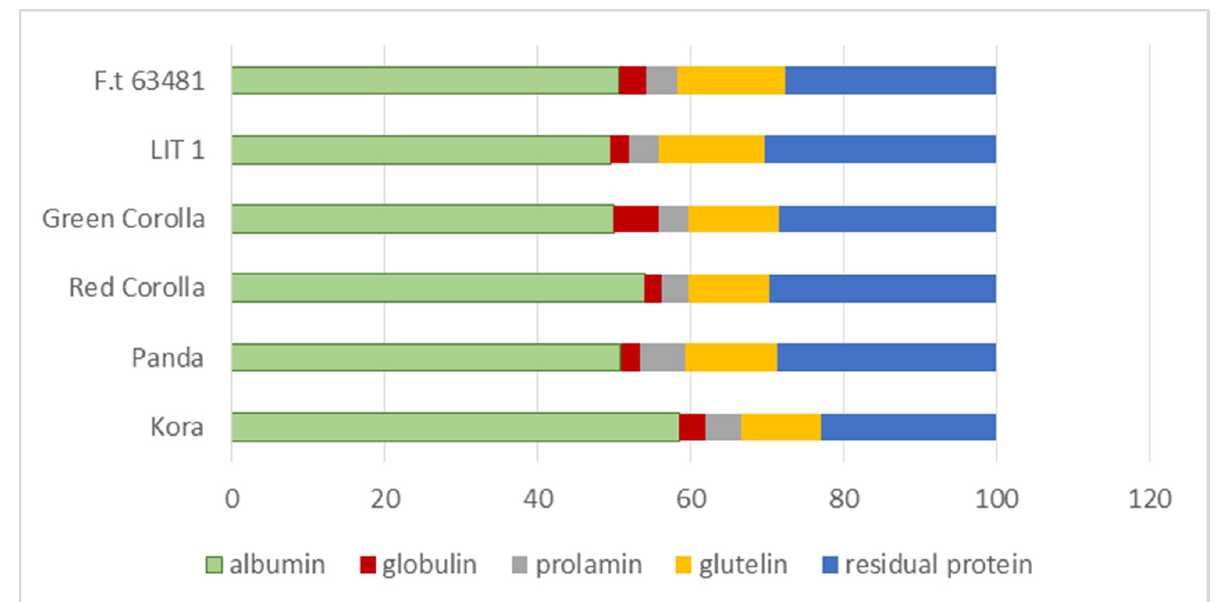
Table 3. Mean values of protein content and distribution of protein fractions in the studied buckwheat genotypes (g/100 g d.m.).